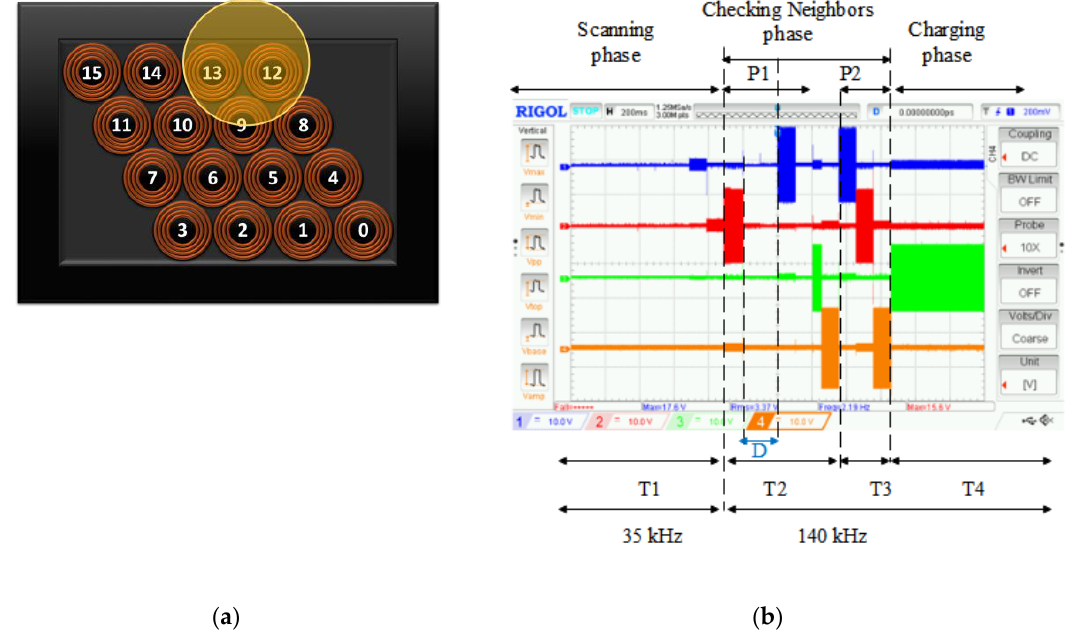
Figure 20. Voltage waveforms during the working procedure ( a ) A 3d illustration of the receiving coil position ( b ) Visualized coils voltages waveform; blue (CH_1) presents the voltage of coil 8, red (CH_2) presents the voltage of coil 9, green (CH_3) presents the voltage of coil 12 and orange (CH_4) presents the voltage of coil 13.